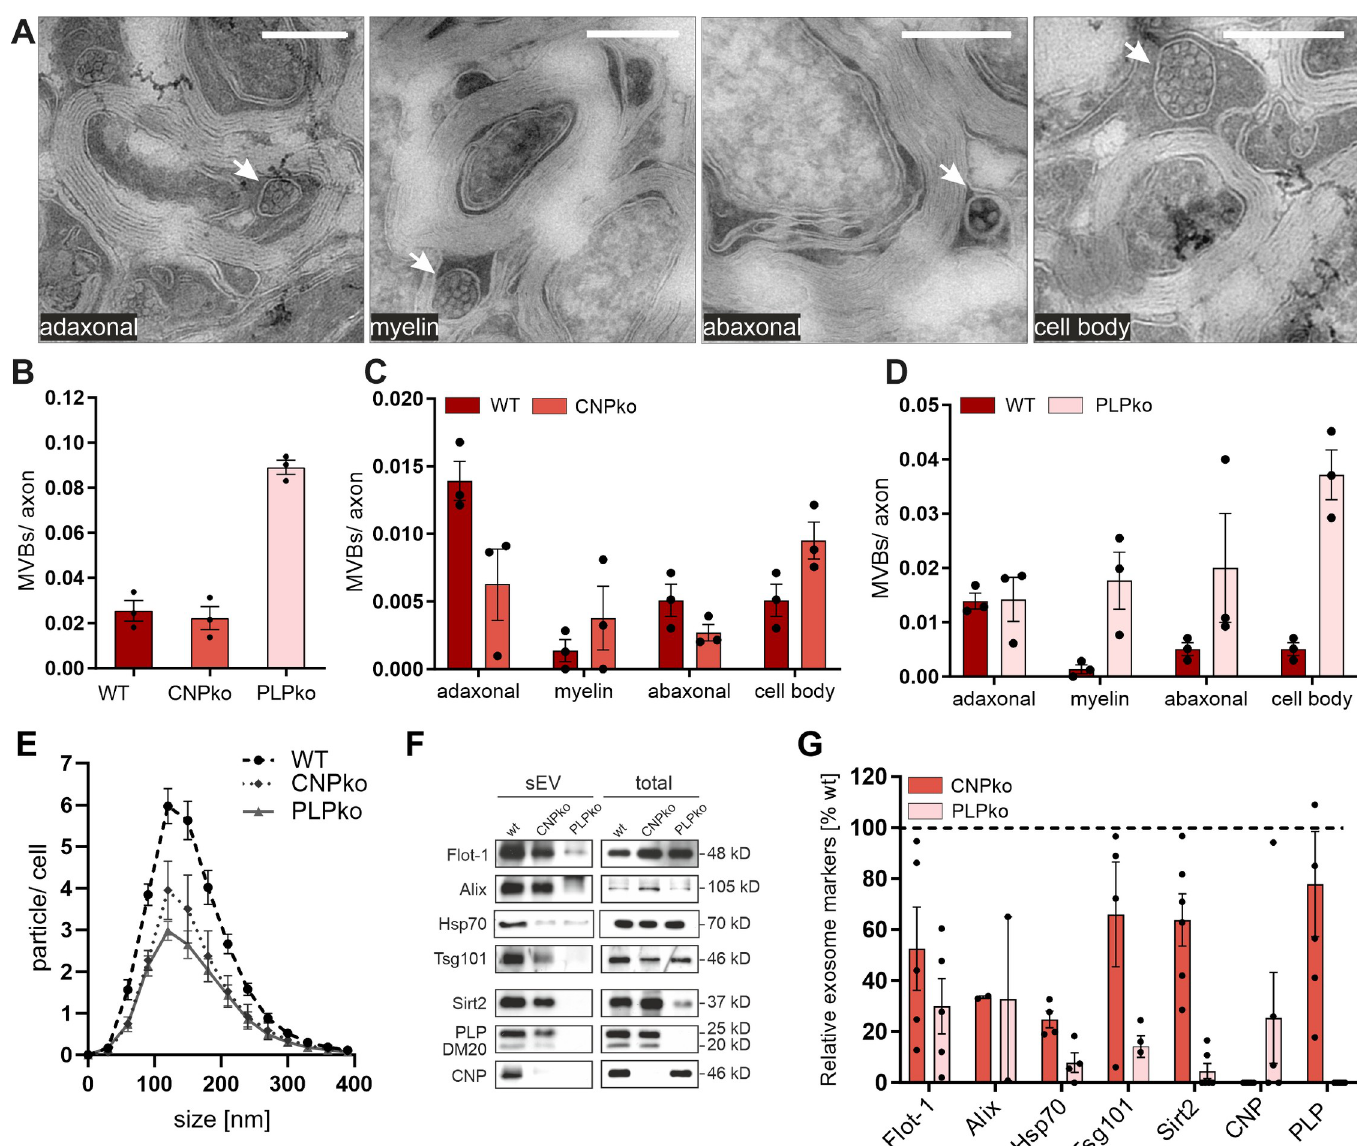
Fig 3. Impaired exosome release from PLP- and CNP-null oligodendrocytes. (A) Representative electron microscopy images taken from optic nerve cross-sections demonstrating MVBs (arrows) in different oligodendrocyte compartments (from left to right): in the inner cytoplasmic loop close to the axon (adaxonal), in cytoplasmic channels within myelin (myelin), in the outer cytoplasmic loop (abaxonal), or in oligodendrocyte cell bodies (scale bar 500 nm). (B–D) Quantification of oligodendrocyte MVBs counted in optic nerves of wild-type (WT), CNP-null (CNP knockout [CNPko]), and PLP-null (PLP knockout [PLPko]) animals and depicted as (B) overall number of MVBs per axon or (C and D) relative number of MVBs located in different compartments as indicated in (A). SEM, n = 3. (E) Nanoparticle tracking analysis of sEVs isolated from WT, CNP-null, and PLP-null oligodendrocytes normalized to the number of secreting cells. SEM, n = 3. (F) Representative Western blot of isolated sEVs derived from equal numbers of WT, CNP-null, and PLP-null oligodendrocytes and (G) densitometric quantification. Signals from sEVs were normalized to the total cell lysate of corresponding sEV-secreting cells and expressed in relation to wild-type levels (dashed line). SEM, n = 2–5. Underlying data and images of blots can be found in S1 Data and S1 Images, respectively. CNP, 2 0 ,3 0 -cyclic nucleotide 3 0 -phosphodiesterase; MVB, multivesicular body; PLP, proteolipid protein; SEM, standard error of the mean; sEV, small extracellular vesicle; WT, wild-type. 3F and 3G). The density of sEVs released by mutant oligodendrocytes appeared normal, as demonstrated by density gradient analysis, indicating that the lipid/protein ratio and sEV sub- types are similar between wild-type and mutant sEVs (S4 Fig). In summary, these data indicate that PLP- and CNP-null oligodendrocytes secrete considerably lower levels of sEVs/exosomes.